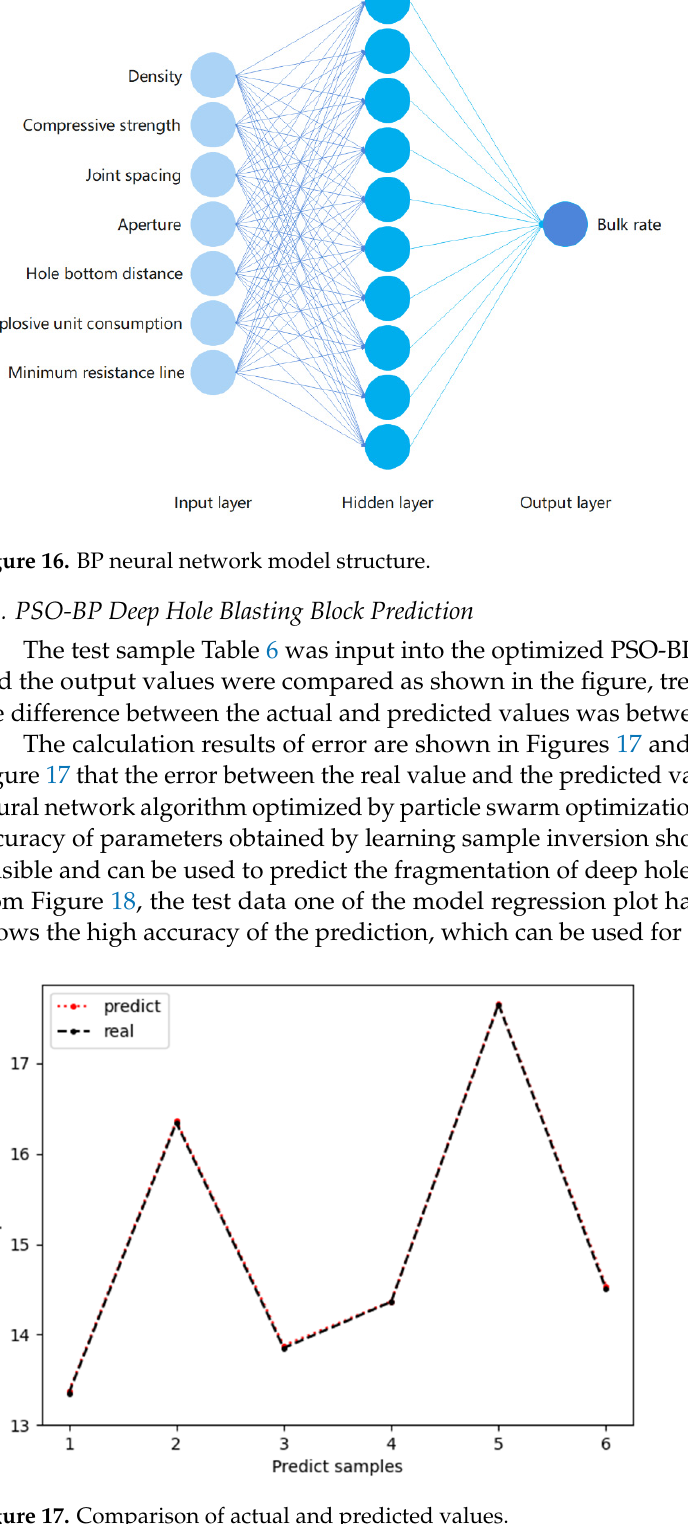
Figure 17. Comparison of actual and predicted values.